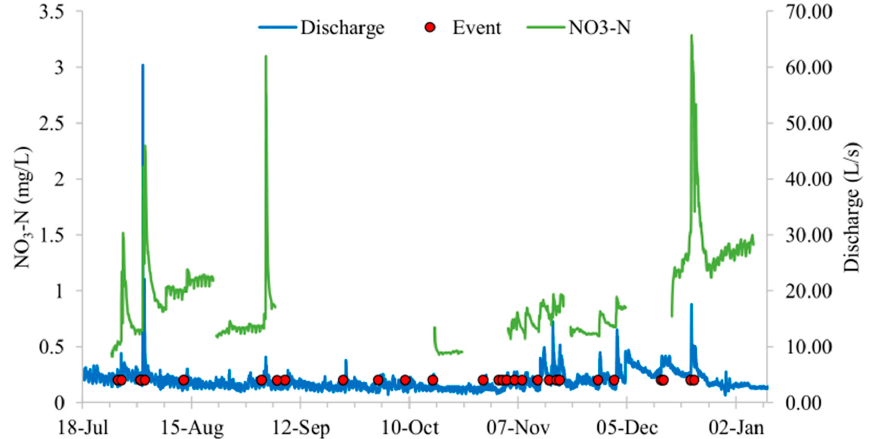
Figure 2. Continuously measured data of discharge and event-based nitrate nitrogen concentration in the stream between 18 July 2019 and 10 January 2020. The red dots indicate approximate time of the individual rainfall-runoff events as defined in this study.